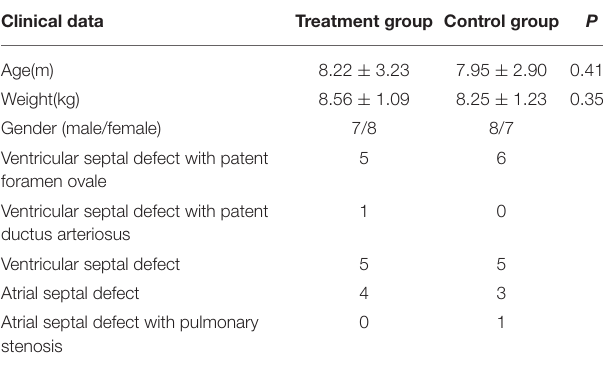
TABLE 1 | General data of Children in both groups ( n =